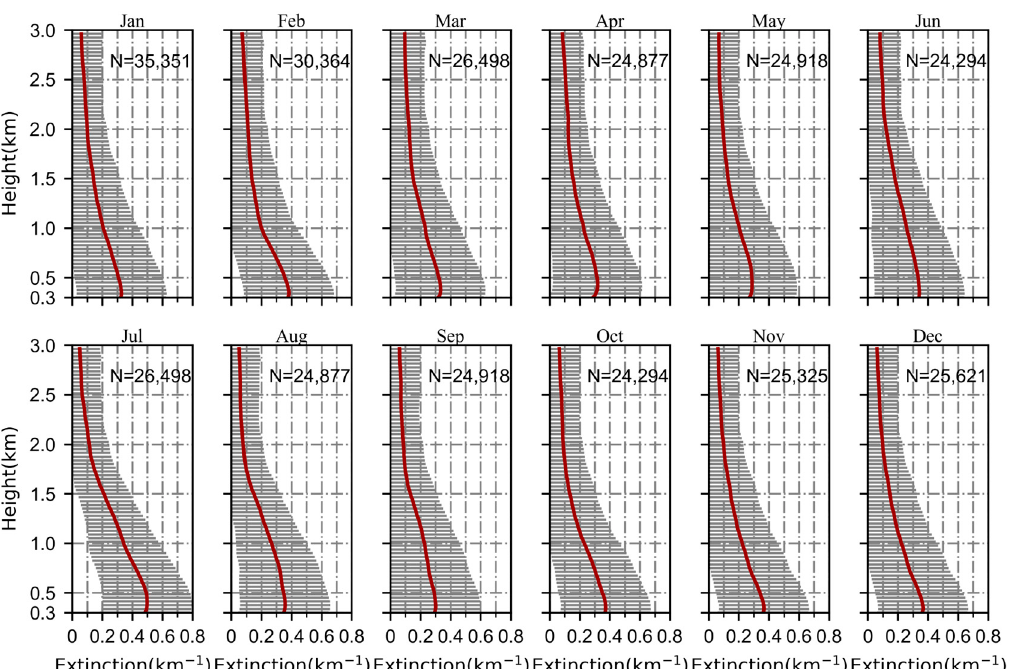
Figure 2. Vertical profiles of the monthly average change in the aerosol extinction coefficient in urban Beijing from September 2017 to February 2021, and the error bars (gray) are standard deviations. Where N denotes the total number of aerosol extinction profiles for each month.